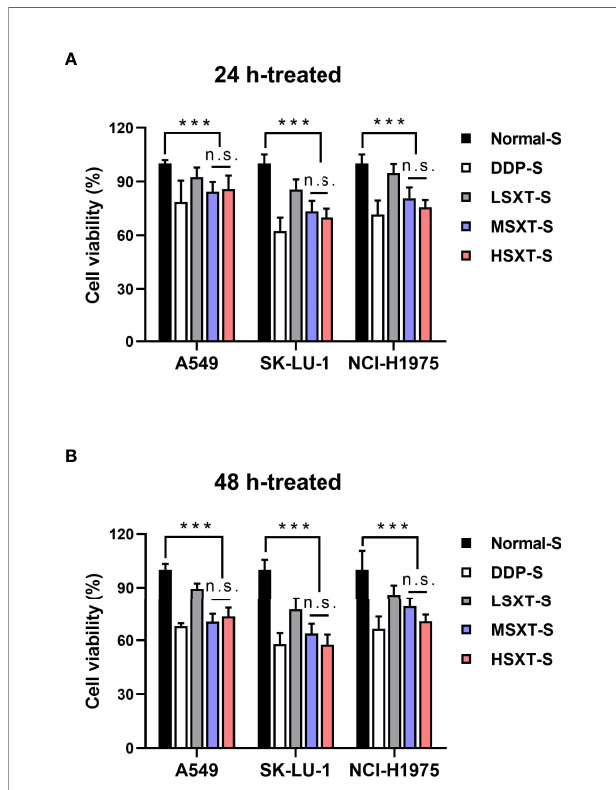
FIGURE 3 | Serum SXT suppresses the proliferation of lung adenocarcinoma cells. Incubation with serum SXT for (A) 24 h and (B) 48 h show obvious cytotoxicity to lung adenocarcinoma cell lines (mean ± S.D., n=10), ***P < 0.001, n.s., no signi fi cance (one-way ANOVA test). Normal-S, normal serum; DDP-S, serum containing cisplatin; LSXT-S, serum containing low-dose SXT; MSXT-S, serum containing medium-dose SXT; HSXT-S, serum containing high-dose